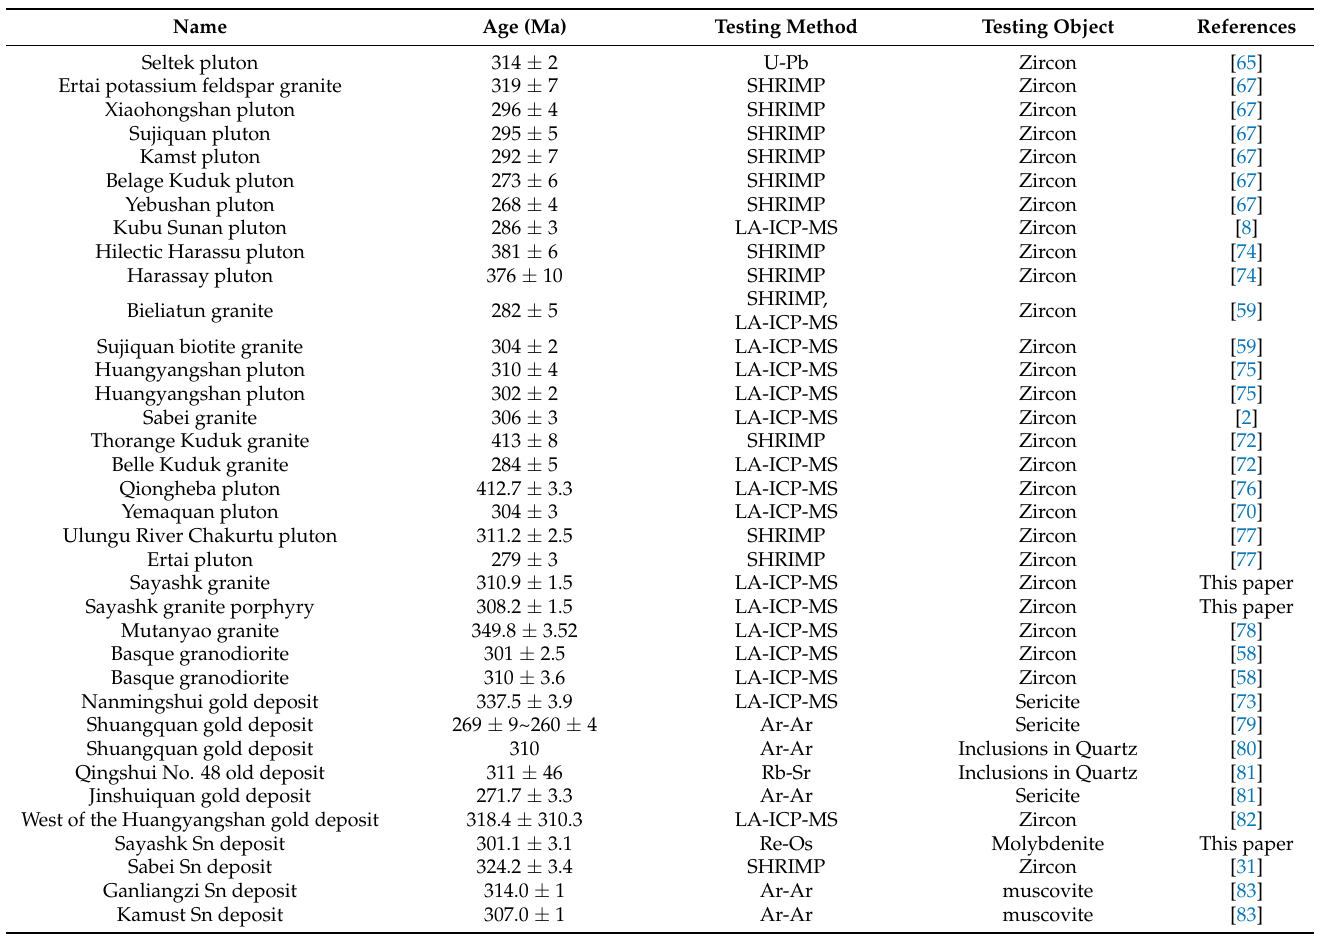
Table 5. Typical intrusions and metal deposits of